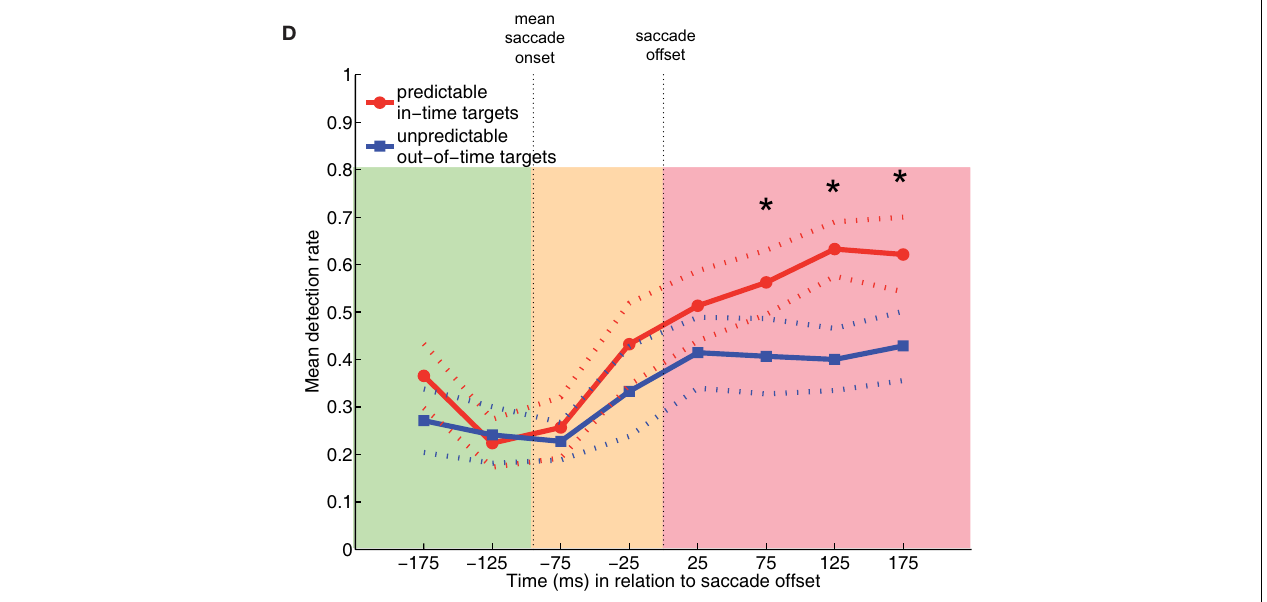
before and 200ms after saccade offset (zoom). Note that bins always included data centered around the time point labeled on the x -axis. For example, the data point at 50 contains detection rates for targets occurring from 0 (saccade offset) to 100ms after saccade offset. (D) Detection rates averaged across bins of 50ms (further zoom) from 150ms before to 200ms after saccade offset. Dashed lines indicate data ± 1 SEM, stars indicate p <